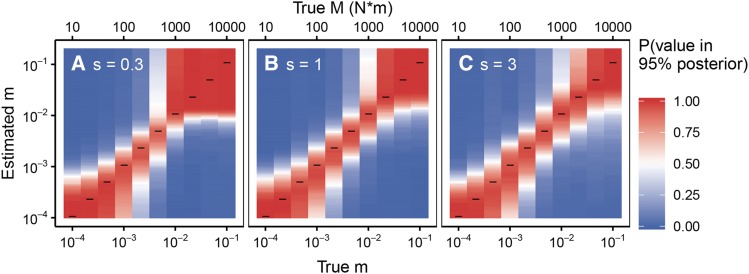
ABC procedure re-estimates true M values in simulated data. 200 simulations are run for each true value of m on the x-axis and 200 posteriors are produced. We plot the proportion of 95% posteriors for a given true m (shown on the x-axis) that include the various values of estimated m (shown on the y-axis). Values that are more red indicate that the posteriors successfully capture the test ‘Estimated m’ value on the y-axis whereas blue values indicate that few posteriors include the y-axis value. Black horizontal lines indicate where the true value matches the y-axis ‘Estimated m.’ Simulations are generated across a gradient of values for m and s (m∈(10−4−10−1),s=(0.3,1,3), sampling at generations (5, T = fixation, T+30,100),N=105).